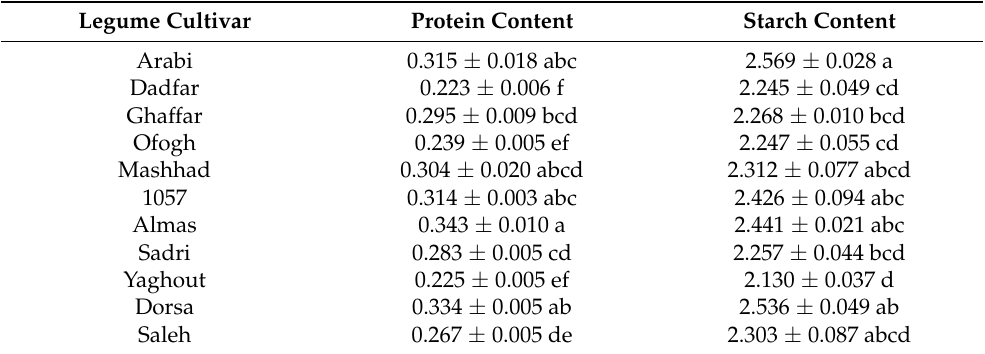
Table 4. Biochemical characteristics (mean ± SE) (mg/mL) of tested different legume leaves.